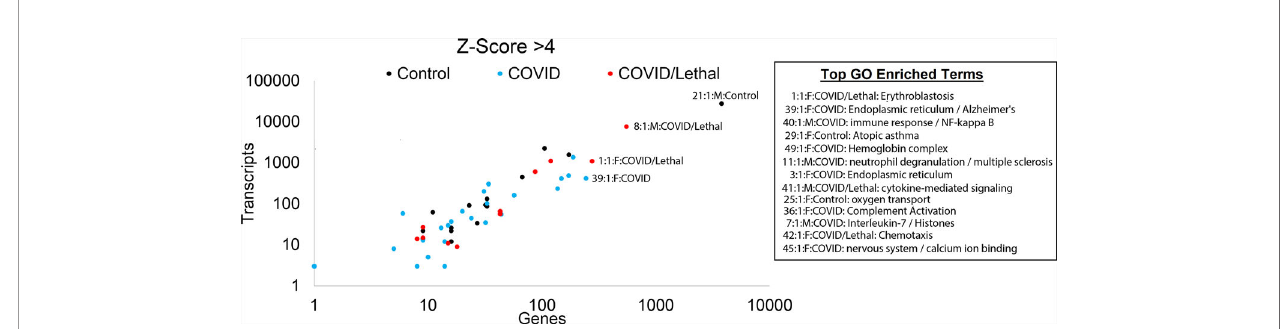
FIGURE 8 | Blood transcriptome outlier gene/transcript signatures of SARS-CoV-2 patients. The number of genes (x-axis) and transcripts (y-axis) in each sample that has a z-score >4. Those samples with enriched gene ontology terms are